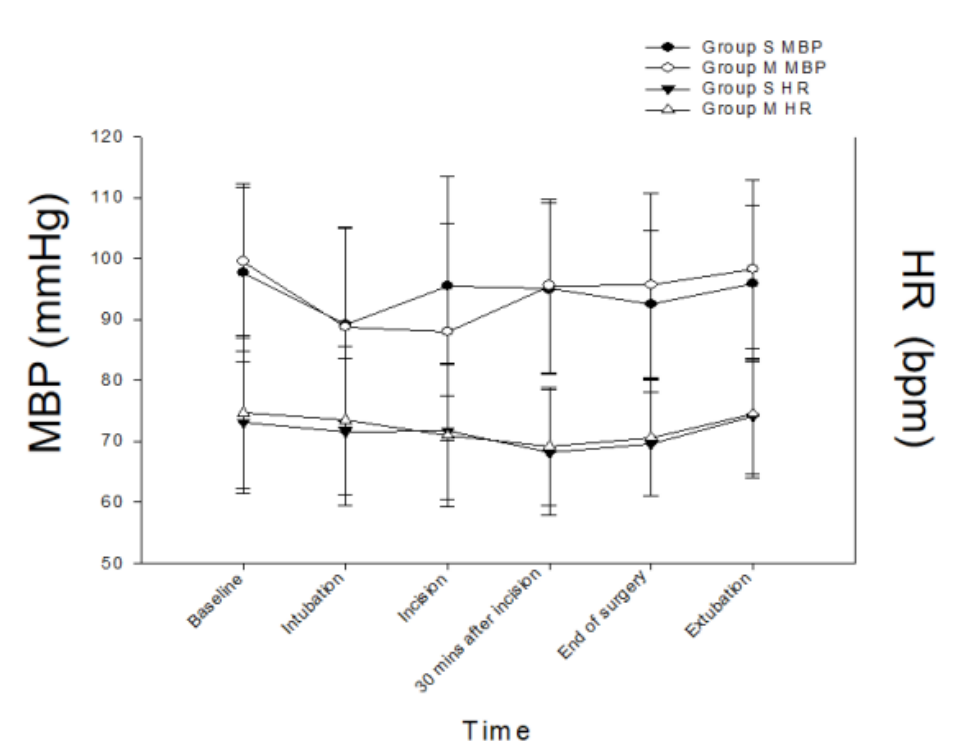
Figure 2. The hemodynamic parameters for both groups at baseline and during anesthetic course. S group: propofol and remifentanil delivered by separate TCI pumps; M group: mixed propofol/rem- Table 2. Perioperative parameters of the two groups.